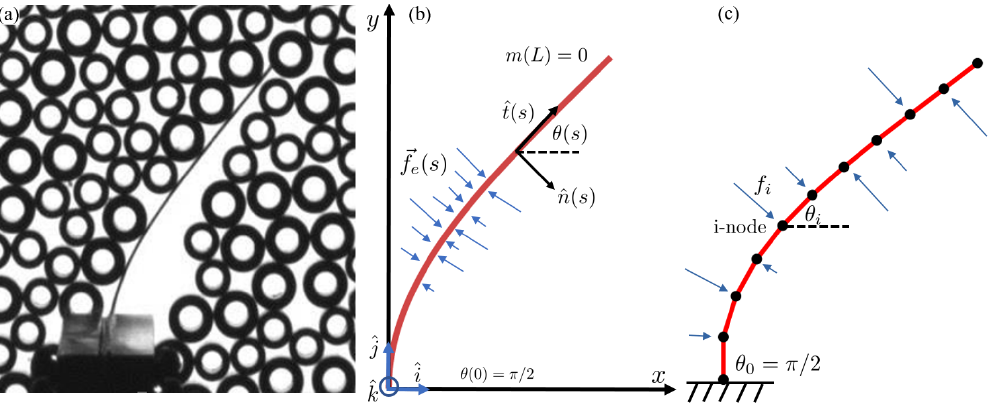
Figure 1. (a) Experimental example of a flexible fiber penetration into a granular medium (from [5]). Grains exert random forces at di ff erent fiber points. (b) Continuous fiber parametrization. Blue arrows represent the local force distribution (cid:126) f e ( s ) for a normal loading with fluctuations of amplitude. (c) Discretized fiber parametrization. Random local forces (blue arrows) act in fiber nodes, where θ i represents the angle of a given segment with respect to the horizontal